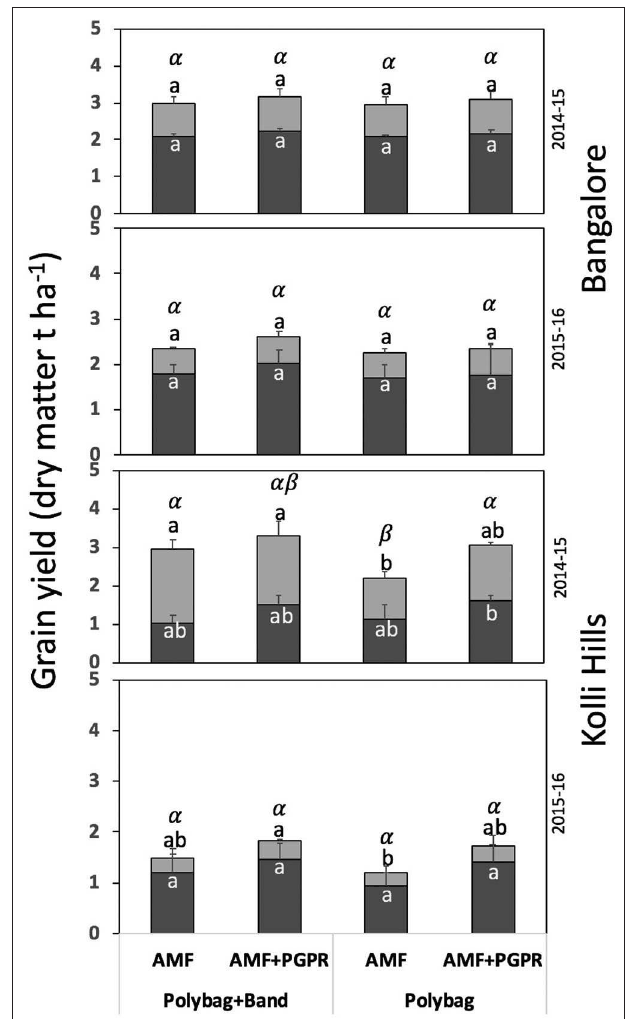
FIGURE 5 | Effect of single inoculation of AMF and combined application of AMF + PGPR in precultured pigeon pea in polybag vs. application in precultured pigeon pea alone and as band in the field on grain yield of finger millet (dark shaded bars) and pigeon pea (light shaded bars) in intercropping system at Bangalore and Kolli Hills during the seasons 2014-15 and 2015-16. Significant differences among means were calculated for total yield of finger millet and pigeon pea. Each error bar indicates + 1 standard deviation of the mean. Alpha ( α ) and beta ( β ) above the bars indicate letters of significance for combined grain yields of finger millet and pigeon pea. Bars not sharing the same letters are significantly different from each other at p <